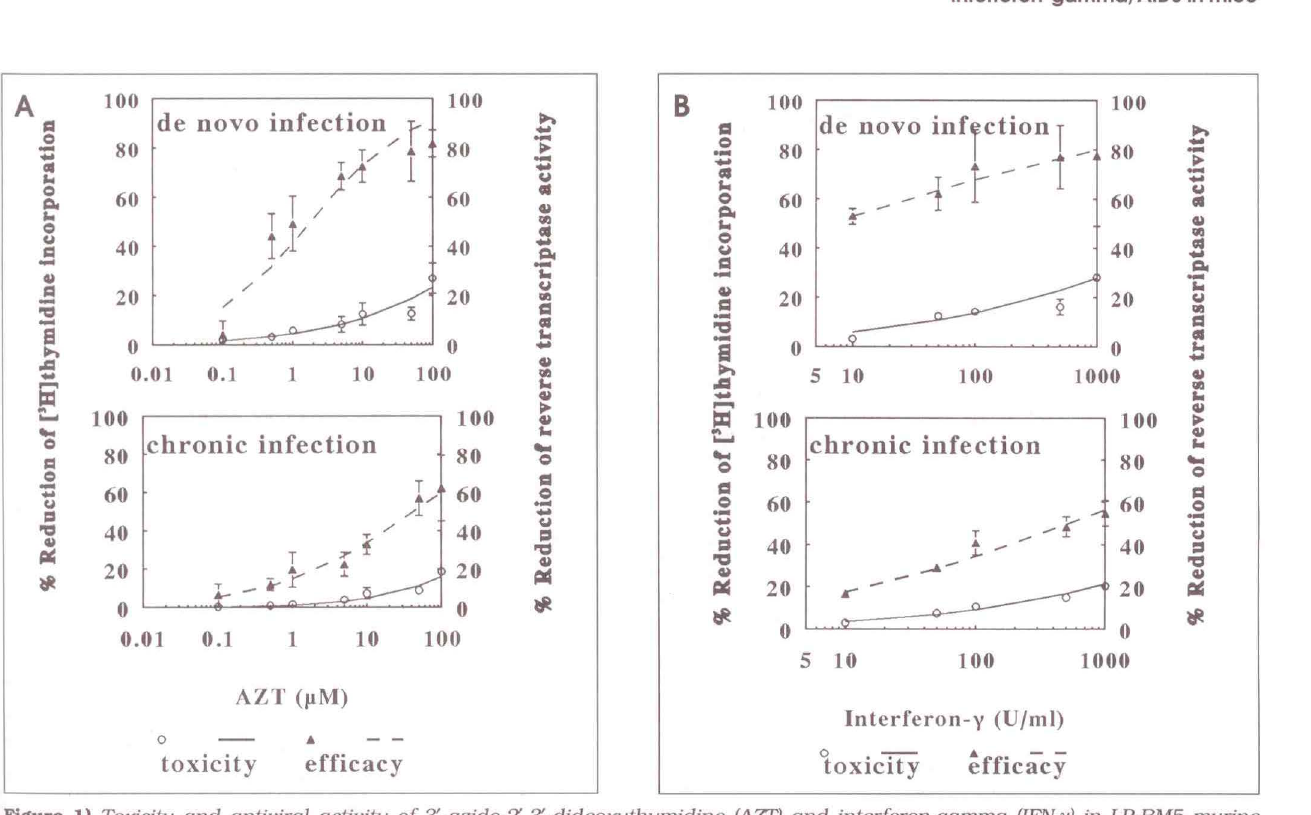
XC-plaque assay: Detection of ecotropic MuLV was essentially performed according to the XC-plaque tech nique described by Rowe and colleagues (34) - carried out with 10 4 cells per well in six-well plates. Syncytia formation was quantified by phase contrast microscopy and using a video camera supported colony counter system (Artek counter 982, Dynatech Lab, Virginia). Bolli methods gave similar counts of